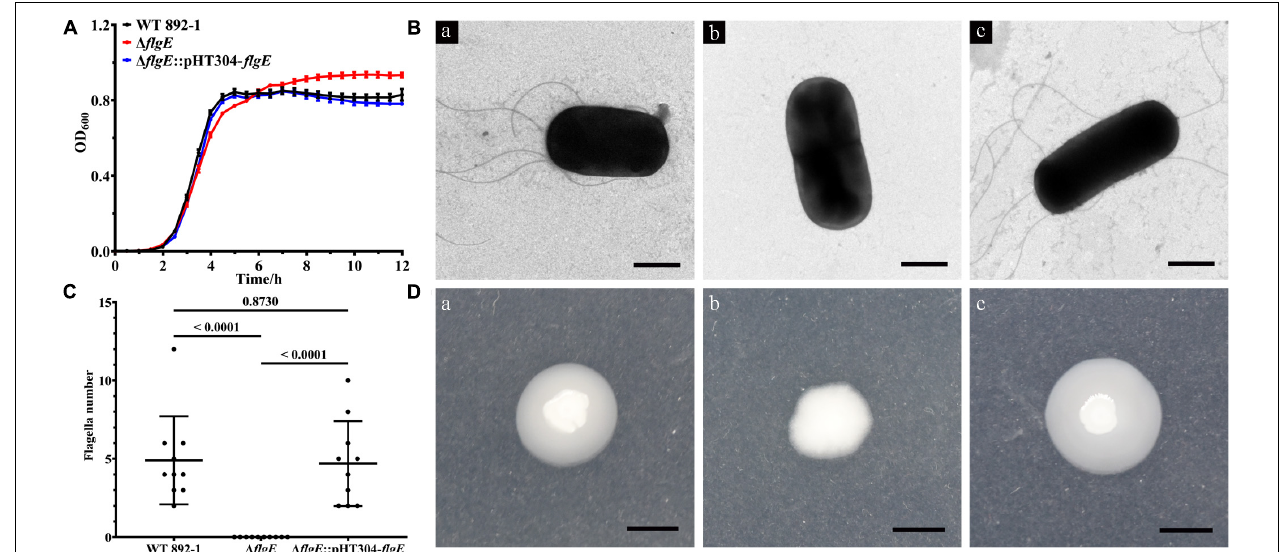
FIGURE 4 | flgE is important for flagella synthesis and function. (A) Growth curves of wild-type, (cid:49) flgE , and (cid:49) flgE :pHT304- flgE . (B) TEM images of flagella produced in the wild-type (a), (cid:49) flgE (b), and (cid:49) flgE :pHT304- flgE (c). Scale bars represent one micron. (C) The number of flagella in wild-type strain, (cid:49) flgE , and (cid:49) flgE :pHT304- flgE . The number of flagella was calculated by 10 bacteria. (D) Swimming motility of wild-type (a), (cid:49) flgE (b), and (cid:49) flgE :pHT304- flgE (c). Scale bars represent zero point five centimeter.